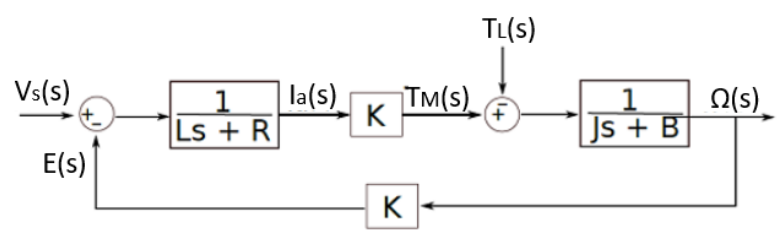
Figure 2. DC motor block diagram.